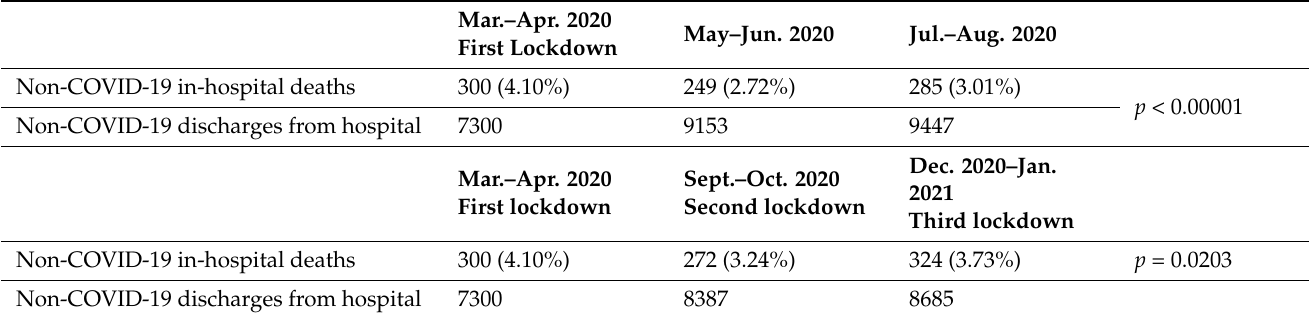
Table 3. Non-COVID-19 in-hospital deaths during the first lockdown compared to May–June